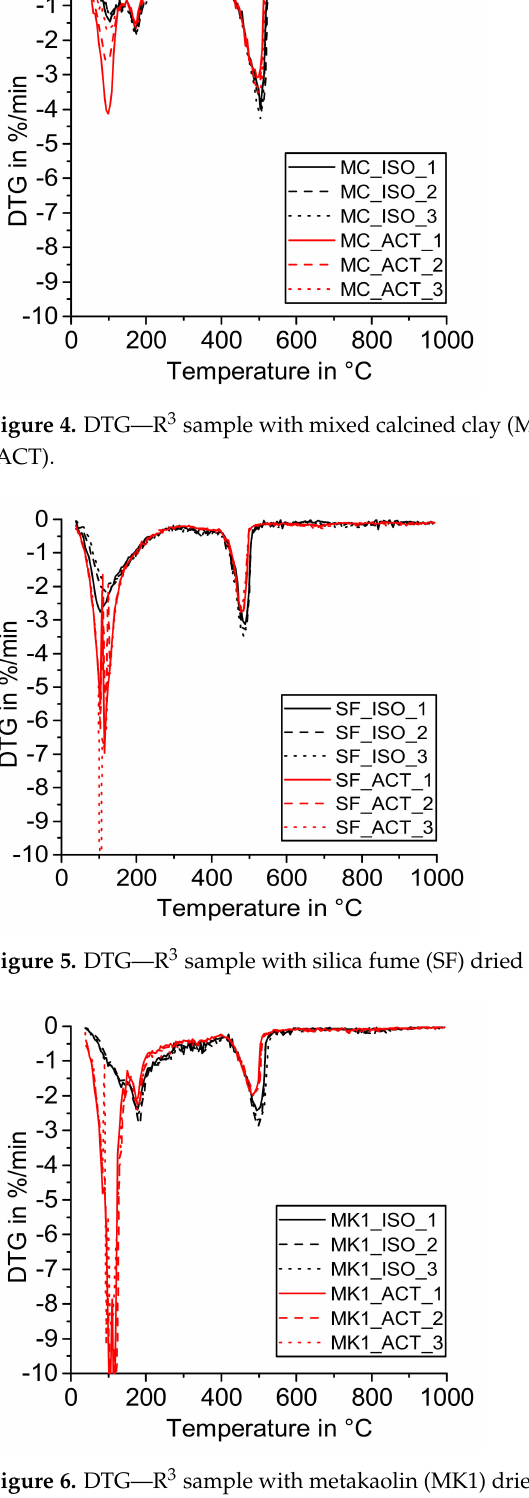
Figure 6. DTG—R 3 sample with metakaolin (MK1) dried with isopropanol (ISO) and acetone